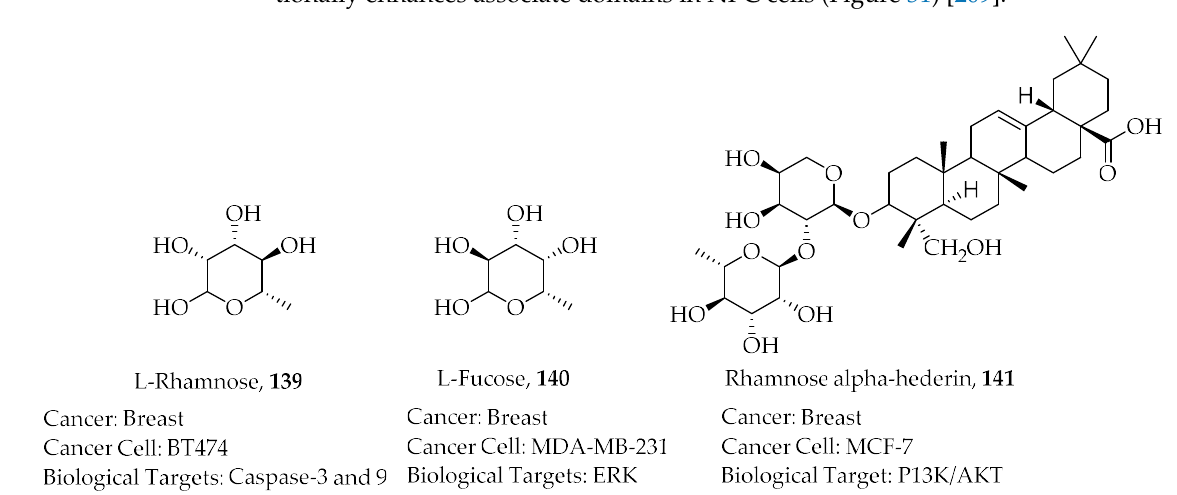
Figure 30. Structures of deoxy sugars L-Rhamnose, L-Fucose, and rhamnose β-hederin with a summary of their biological activity towards selected cancer targets.